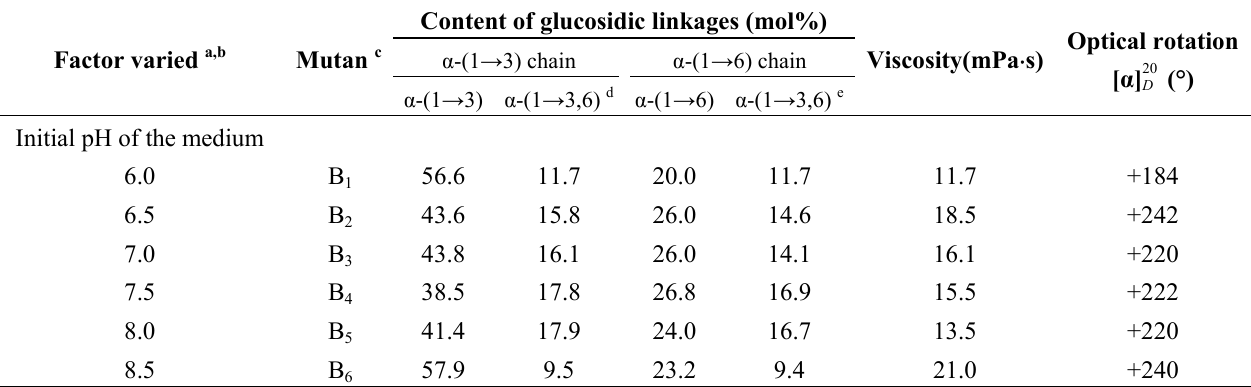
Table 2. Structure and some properties of mutans produced under different culture conditions by S. sobrinus / downei 21020 grown in medium